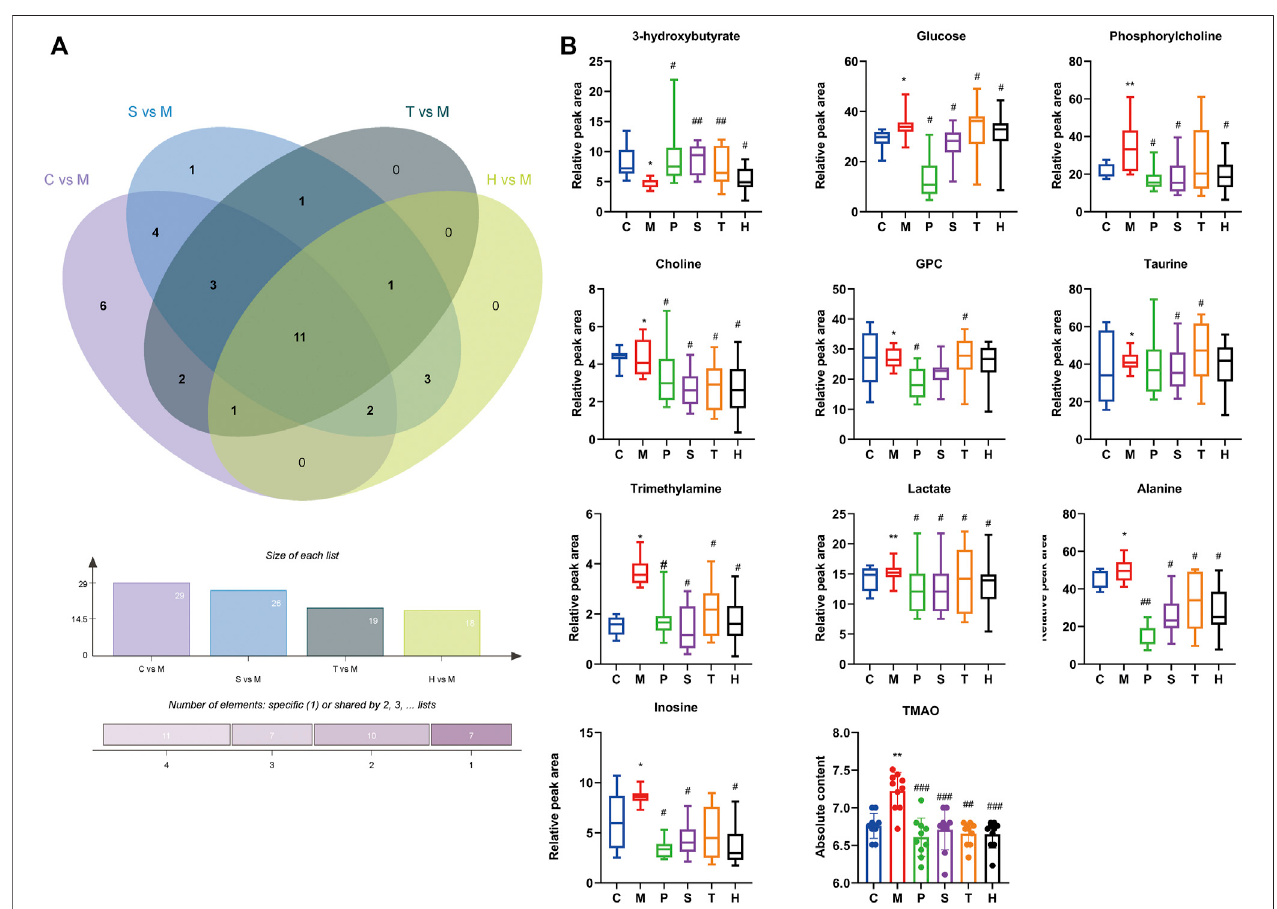
FIGURE2| Differential metabolites inmice liverbetweendifferent groups. (A) Intersection differential metabolites changesin Cvs.M, Svs. M, Tvs. M, and Hvs. M by Venny analysis. (B) Individual relative content changes of differential metabolites in common were represented by the boxplot. * p < 0.05, ** p < 0.01, *** p < 0.001, vs. C; # p < 0.05, ## p < 0.01, ### p < 0.001 vs. M. C: control; M: model; P: pioglitazone; S: salidroside; T: tyrosol; H: